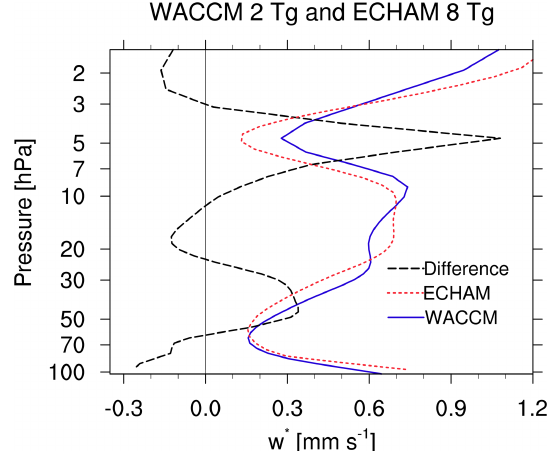
Figure 11. Residual vertical velocity in the tropics for a WACCM simulation with an injection rate of 2Tg ( S ) yr − 1 (blue), ECHAM simulation with an injection rate of 8Tg ( S ) yr − 1 (red) and the dif- ference (black, (WACCM − ECHAM) /